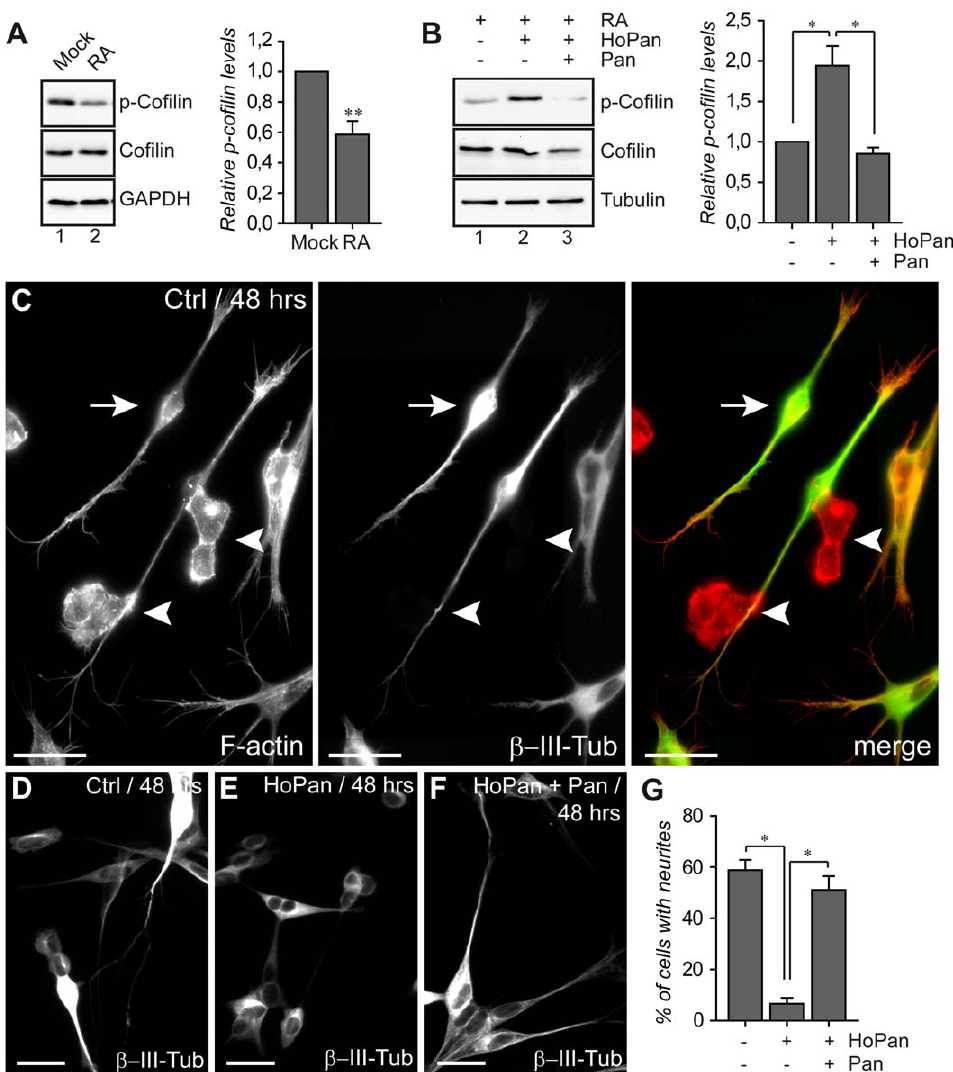
Figure 5. HoPan induces accumulation of phospho-cofilin and affects neurite formation in neuronal differentiation invitro . ( A ) Undifferentiated and retinoic-acid (RA) differentiated SHSY-5Y cells were lysed and levels of total and phosphorylated-cofilin were assayed using Western blot analysis with specific antibodies. Representative blots are shown. GAPDH was used as an additional loading control. Levels of p-cofilin were quantified from 2 independent experiments. The p-cofilin/cofilin ratio was set as 1 in mock treated cells. ( B ) RA-differentiated SHSY-5Y cells were additionally treated with HoPan or HoPan and pantethine. Levels of p-cofilin were assayed and quantified as in A. ( C ) Control SHSY-5Y cells were differentiated with RA, plated on poly-lysine and analyzed after 48 hours for their morphology (using rhodamin-phalloidin marking F-actin, red) and differentiation status (using b -III-Tubulin staining, green). In RA-treated cultures undifferentiated and differentiated cells are visible. Undifferentiated cells showed very short filopodia and did not express b -III-Tubulin (indicated as arrowheads). 48 hours after seeding many differentiated cells showed an elongated shape, neurite growth and high expression of b -III-Tubulin (indicated as arrows). ( D–F ) Control (D), HoPan (E) or HoPan plus pantethine (F) treated cells were differentiated with RA and plated on poly-lysine. 48 hours after seeding cells were fixed and stained for b -III-tubulin, representative parts of cell morphology and b -III-Tubulin staining of the different conditions are shown. The percentage of neurite-bearing cells was calculated for each condition. Scale bars represent 25 m m ( C–F ). ( G ) Quantification of cells showing b -III-Tubulin positive neurites is